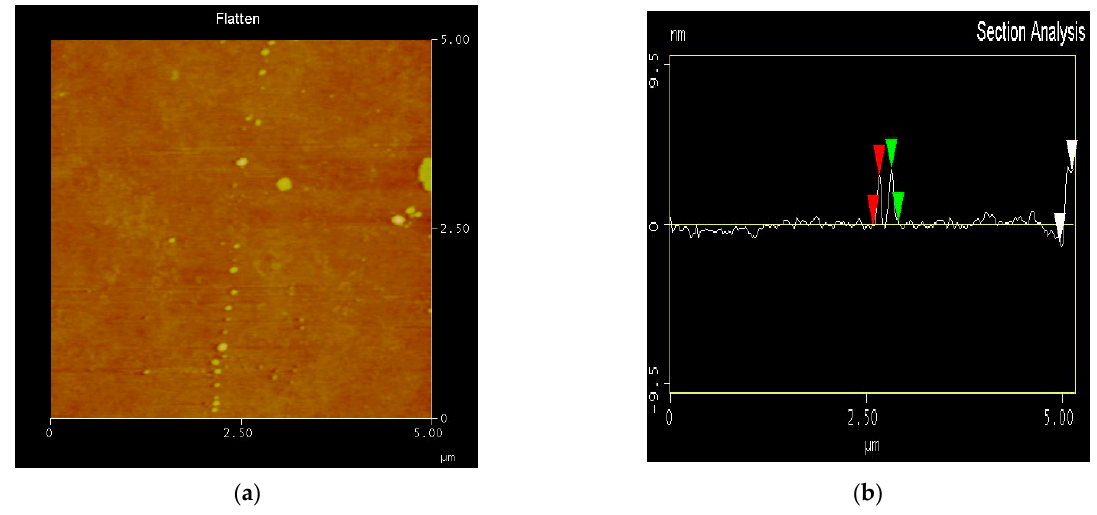
Figure 2. AFM spectra of composite ( a ) external surface morphology ( b ) height profile.